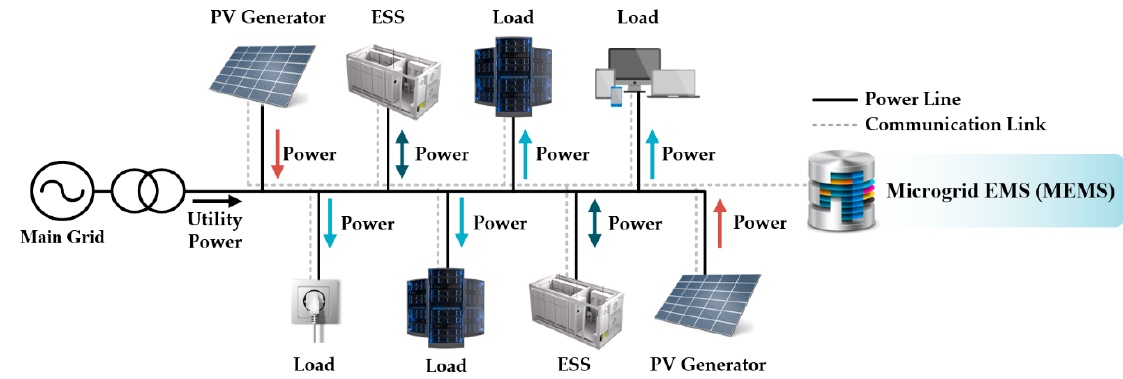
Figure 3. Configuration of a grid-connected microgrid (MG).